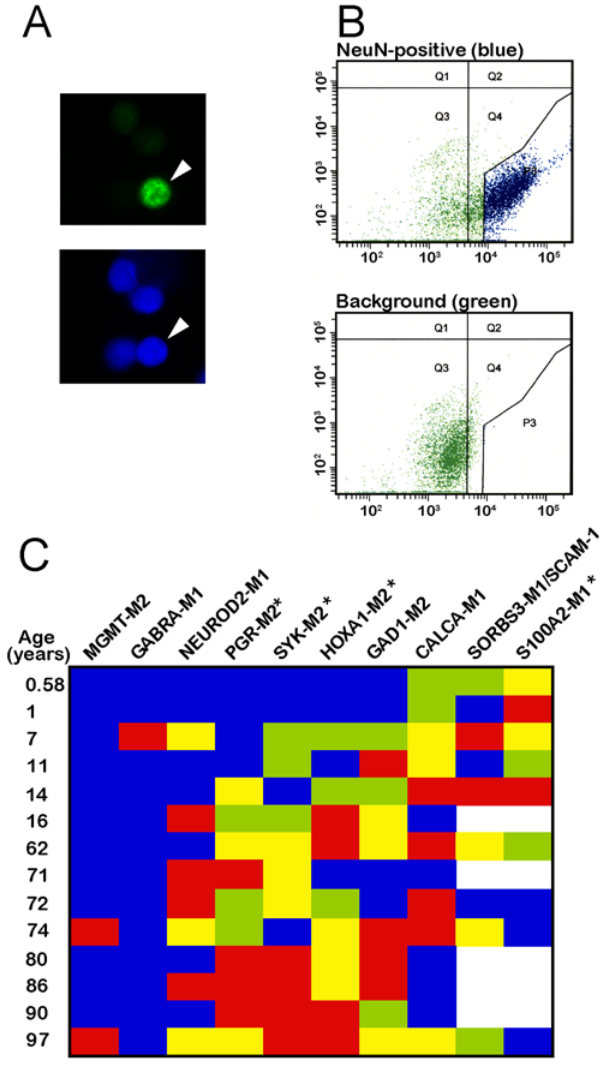
Figure 5. Age-related DNA methylation changes in differentiated neurons. ( A ) Examples of nuclei stained with anti-NeuN (green) and counterstained with DAPI; arrowhead marks double-labeled cell. Notice absence of detectable background and autofluorescence in these samples that were processed without prior fixation ( B ) Representative FACS of unfixed NeuN labeled material similar to the one shown in (A) (top) and of negative control (bottom); blue dots mark sorted neuronal nuclei (NeuN + ). ( C ) Heatmap showing methylation levels of neuronal DNA isolates for 10 different genes across the lifespan (range: 0.6– 97 years). Each gene is grouped into quartiles (blue=1 low, green=2 medium-low, yellow=3 medium high, red=4 high extent of methyl- ation). The larger the number of samples with no detectable methylation, the fewer the number of observations coded green and yellow. White space=no data. *=p , 0.05 , Mann-Whitney U permuta- tion based on comparison of immature/young (0.6–16 years) to old (62 + years) samples. Notice that neuronal DNA from advanced age group shows significant increase in DNA methylation for 3/10 gene loci ( PGR, SYK, HOXA1 ), but decreased levels at S100A2